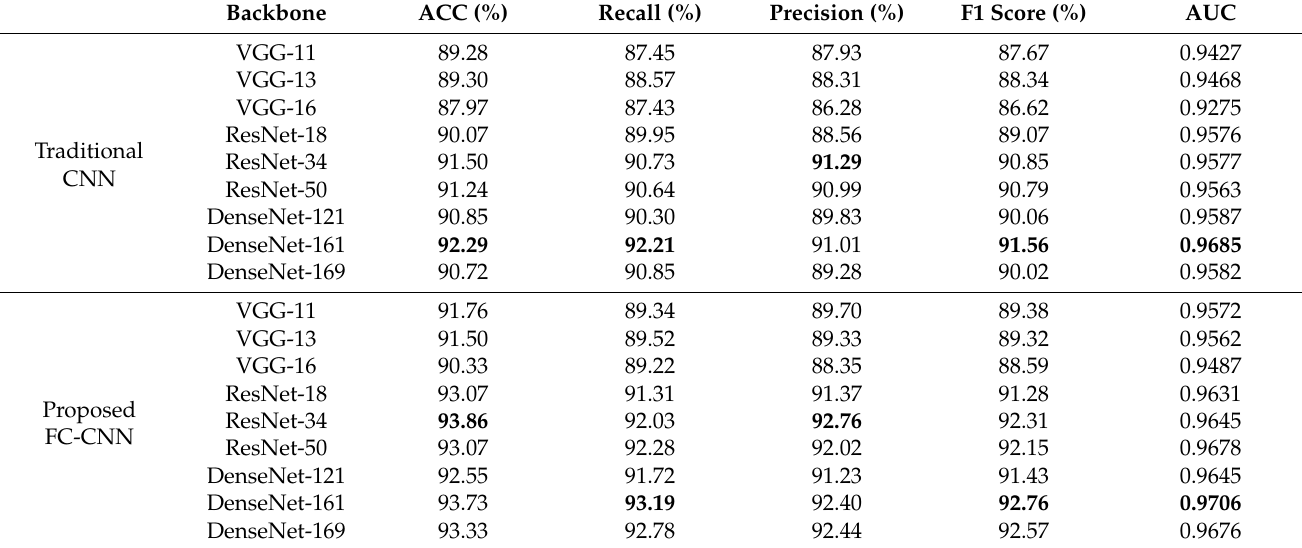
Table 2. Performances of traditional CNN and the proposed FC-CNN for backbone networks. Backbone ACC (%) Recall (%) Precision (%) F1 Score (%) AUC